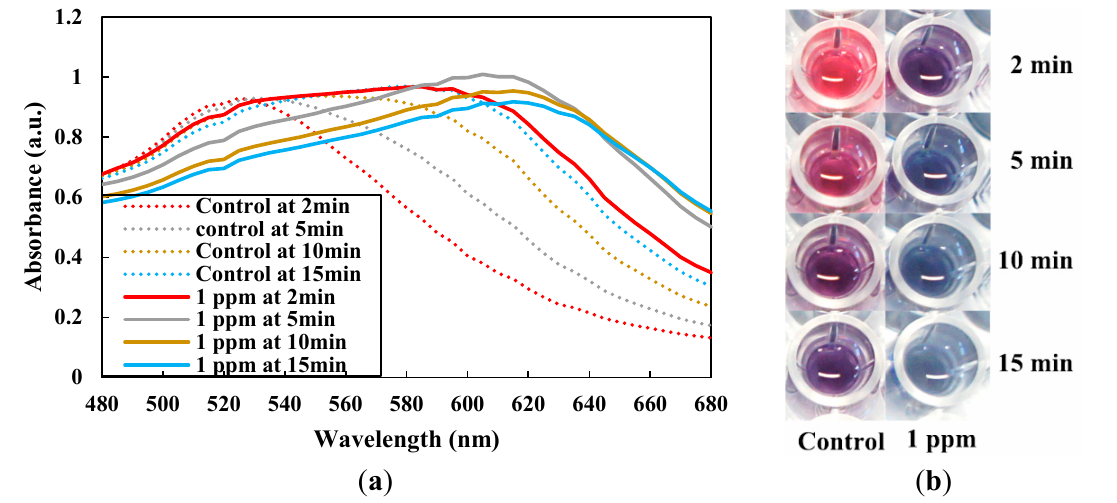
Figure 2. ( a ) Evolution of the absorbance of the control solution (dotted lines) and the solution with 1 ppm lead (solid lines) in the visible spectrum range; and ( b ) the solution colour changes corresponding to different incubation times.